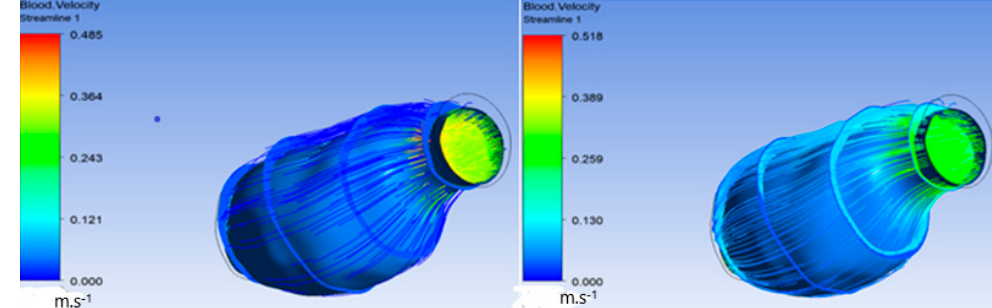
Figure 10. Streamlines penetrating ILT surface.